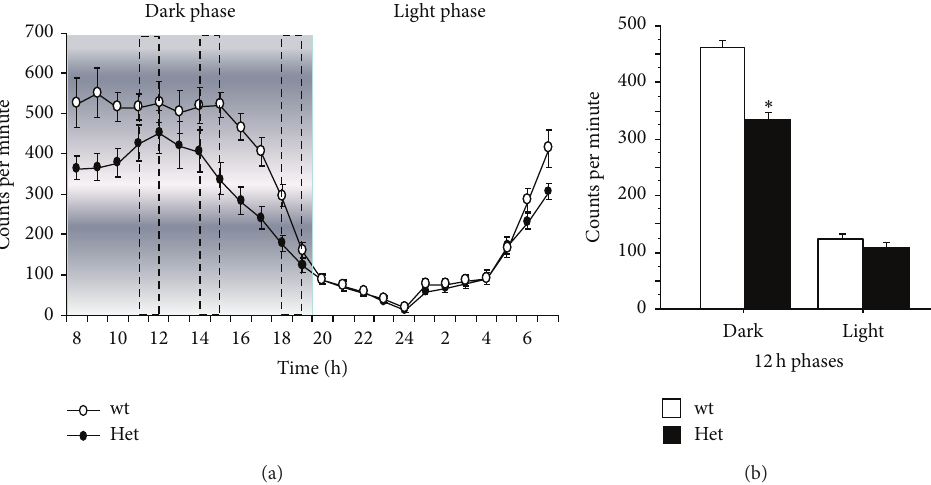
Figure 2: Daily spontaneous locomotor activity in the home-cage . MeCP2-308 heterozygous female mice (Het, 𝑁 = 13 ) showed decreased home-cage spontaneous circadian locomotor activity compared to age-matched wild-type controls (wt, 𝑁 = 15 ) during the dark/active phase of the L/D cycle. Mice were individually housed in the home-cages and locomotor activity was automatically recorded. The infrared sensors detected any movement of mice with a frequency of 20 events per second. Scores were obtained as counts per minute expressed during 1h periods, and the 24 h profile of daily activity was obtained by averaging 7 days of continuous registration. (a) Representation of the 24 h activity profile, Het (black circles) and wt mice (white circles). The area evidenced in gray represents the dark/active phase of the day and the dash lines indicate the intervals during which the spontaneous behaviours in home-cages were scored by the experimenter (see Figure 3). (b) Representation of the 12 h activity profile. Data are expressed as mean ± SEM. ∗ 𝑃 < 0.05